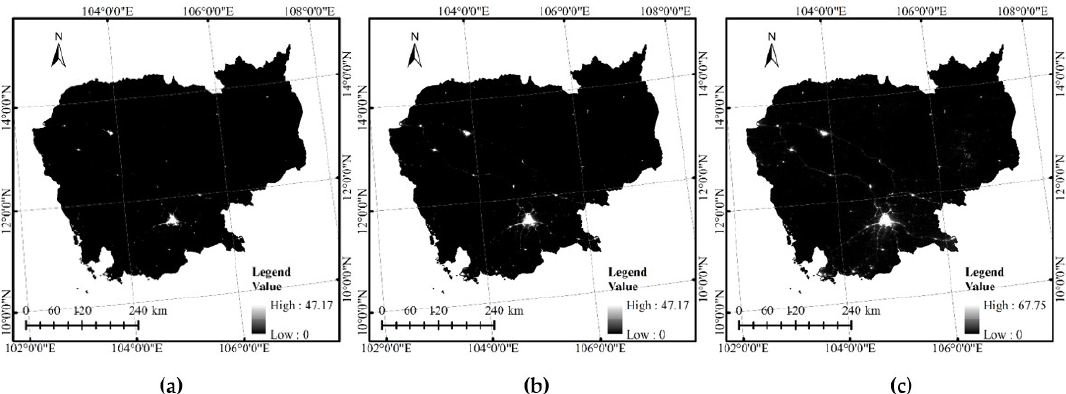
Figure 5. Annual night-light images of Cambodia obtained by month-specific substitution for the years ( a ) 2012, ( b ) 2015, and ( c ) 2018. years ( a ) 2012, ( b ) 2015, and ( c ) 2018.